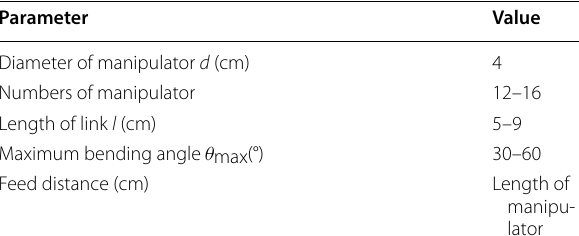
Table 1 Main parameters of the modular manipulator